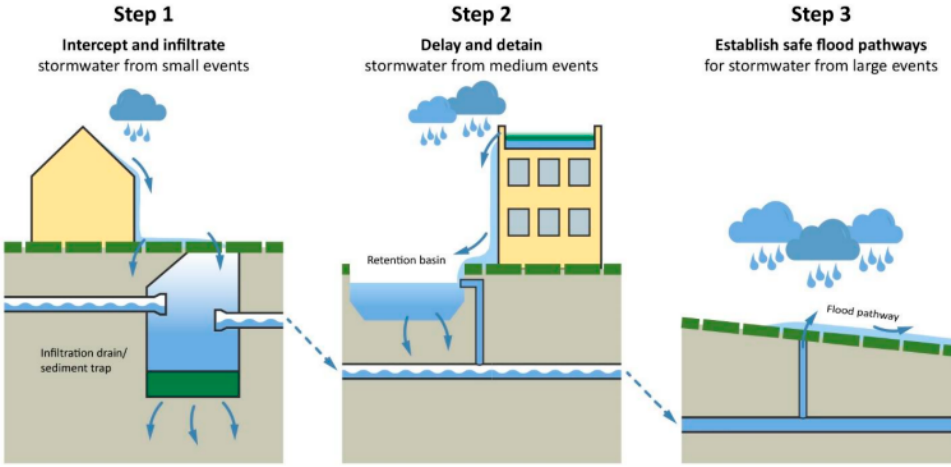
Figure 1. Norwegian three-step strategy for stormwater management. Illustration: Klima 2050/SIN- TEF [21].